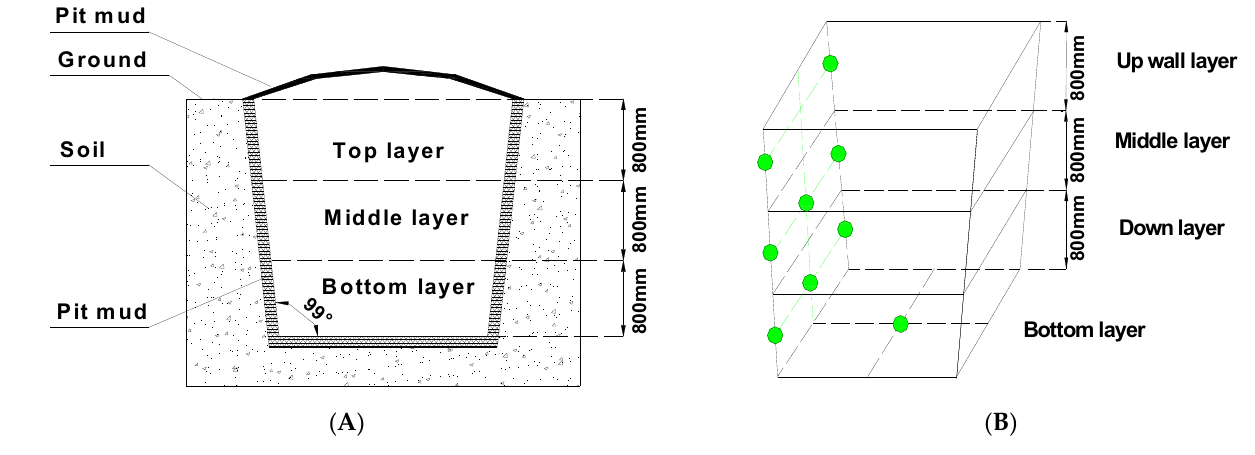
Figure 1. The profiles of the Chinese strong-flavour liquor pit mud ( A ) and the sampling sites of pit mud ( B ). The green dot means each pit mud sampling site of cellar.